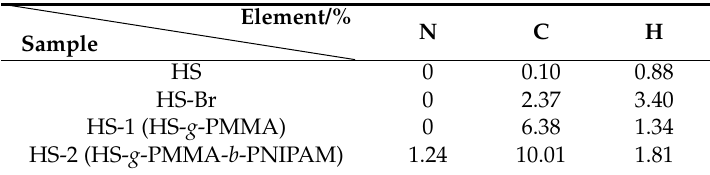
Elemental analysis of hollow spheres (HS), HS-Br, HS-1 (HS- g -PMMA), HS-2 (HS- g -PMMA- b -PNIPAM).